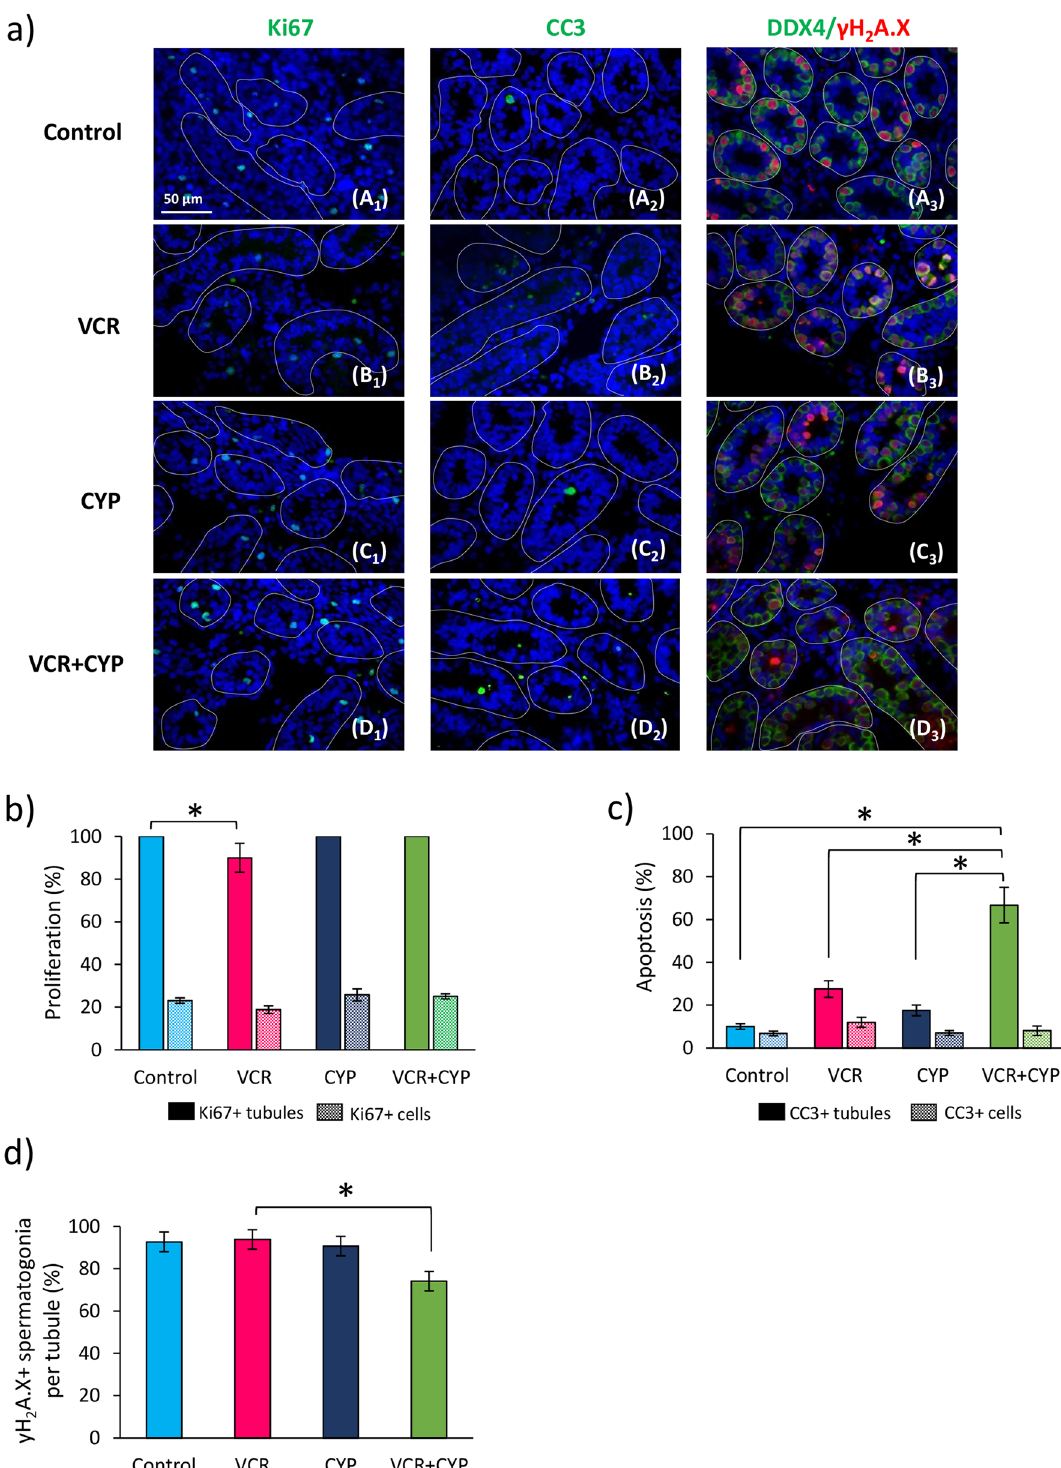
Figure 2. Impact of chemotherapy prepubertal exposure on intratubular cell before organotypic culture. (a) Representative images of Ki67 (A1-D1) and cleaved caspase-3 (A2-D2) immunofluorescence and combined detection of γH 2 A.X and DDX4 (A3-D3) in testicular tissues from 6 d pp control mice or VCR, CYP or VCR+CYP-treated mice. Testicular tissue sections were counterstained with DAPI (blue). (b) The percentage of intratubular cell proliferation (Ki67+ tubules in solid colour and Ki67+ cells in hatch colour) and (c) apoptosis (Caspase 3+ tubules in solid colour and cleaved caspase 3+ cells in hatch colour) were quantified for control, VCR, CYP and VCR+CYP groups. Double γH 2 A.X and DDX4 immunofluorescence was performed to determine the percentage of spermatogonia with DNA double-strand breaks for each condition (d) . Data are expressed as means ± SEM with n = 4 mice for all groups. A value of * P < 0.05 was considered statistically significant. Magnification